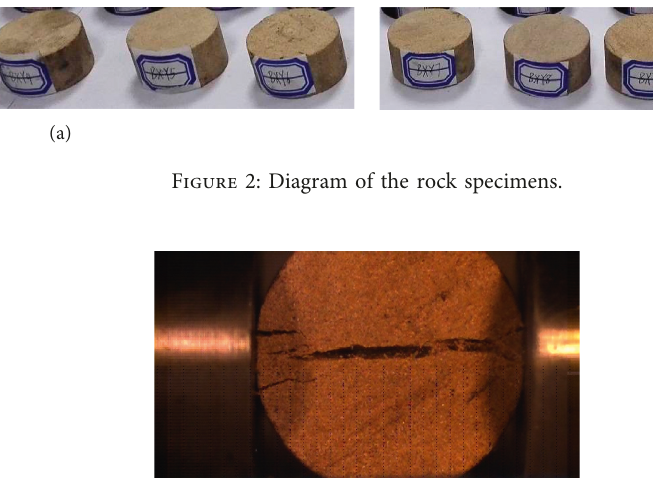
Figure 3: Destruction process images for rock specimen under SHPB impact damage.